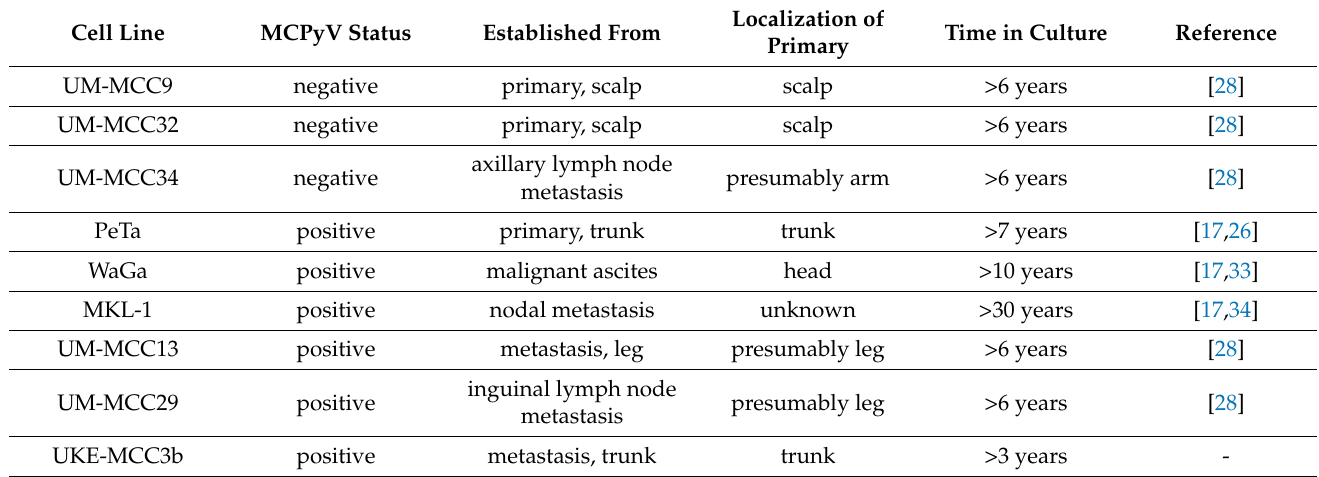
Table 2. Overview of analyzed Merkel cell carcinoma cell